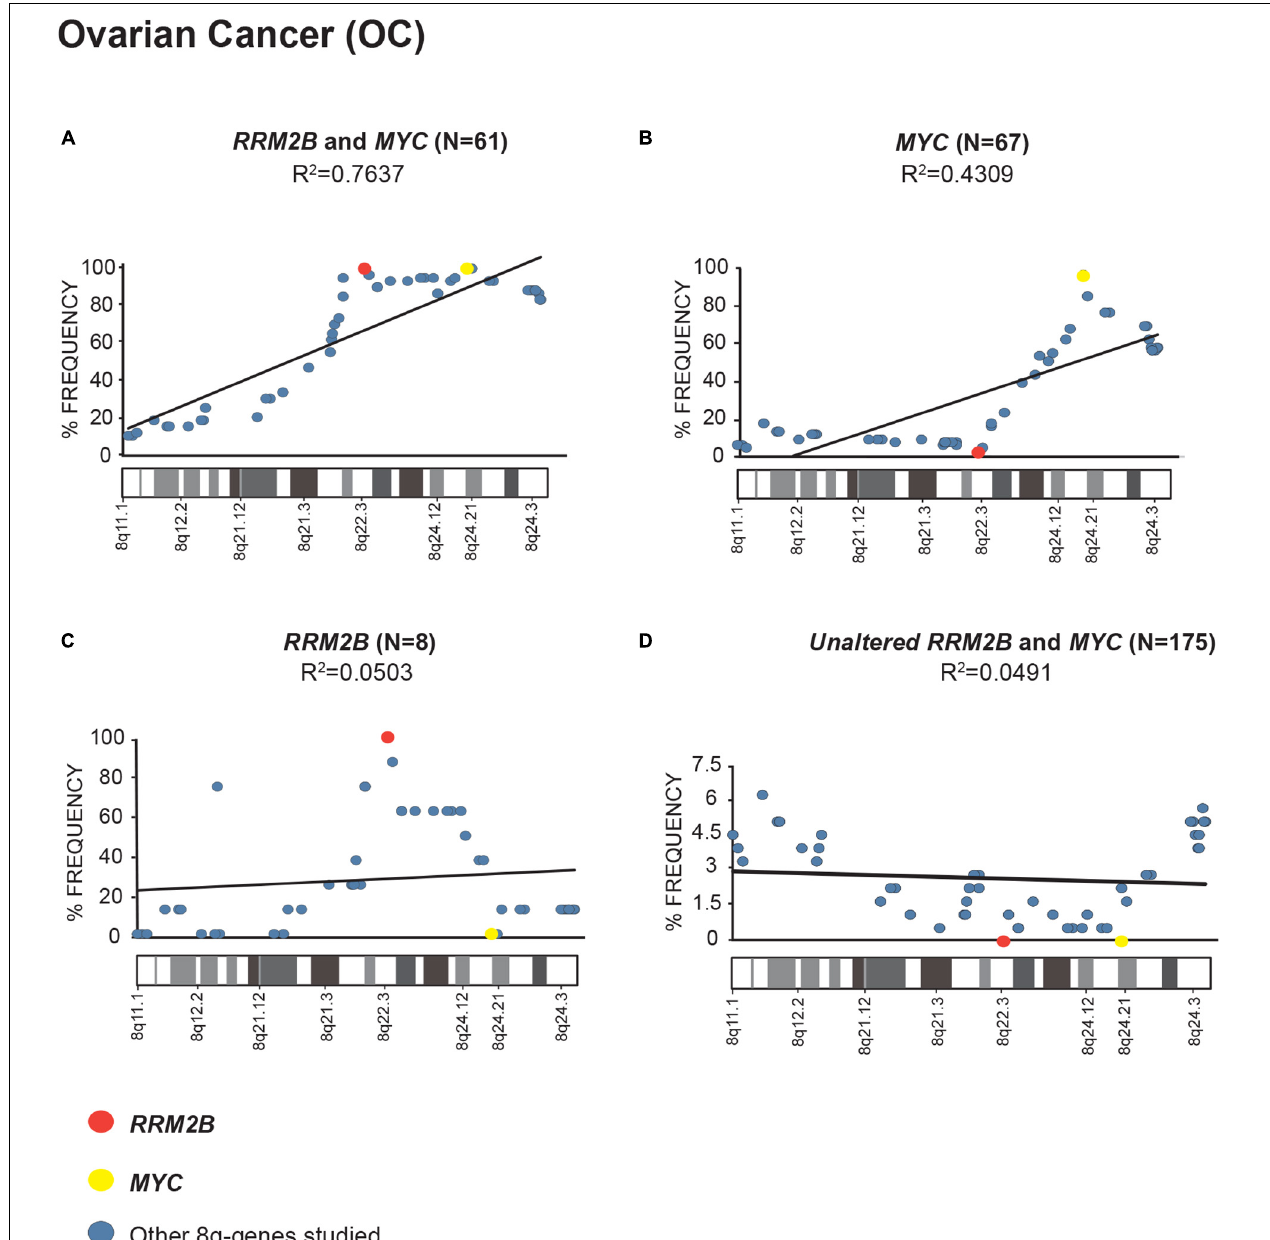
FIGURE 2 | Amplification frequency of 8q-genes in ovarian cancer (OC). (A) cases with co-amplification of RRM2B and MYC ; (B) cases MYC only amplification; (C) cases RRM2B only amplifications; (D) cases with neither (unaltered) were plotted as percent of frequency for amplifications in various 8q-region genes relevant for cancer (see Supplementary Table 1 ). RRM2B (red circle), MYC (yellow circle), and other genes (blue circle). The Pearson correlation ( R 2 value) for the data points is represented by a black trend line.